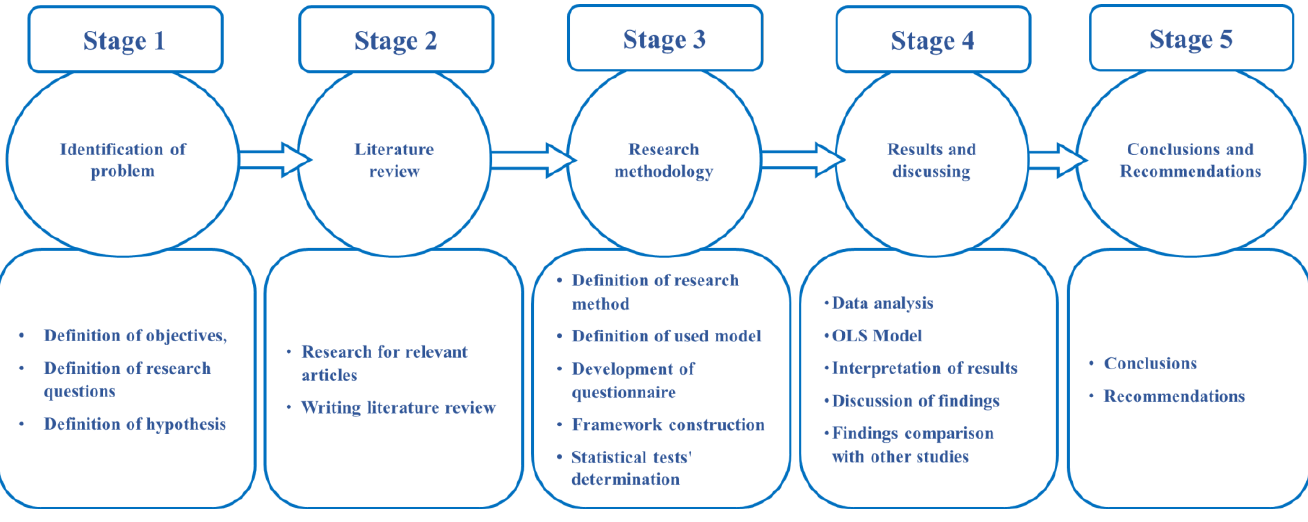
Figure 2. Flowchart of